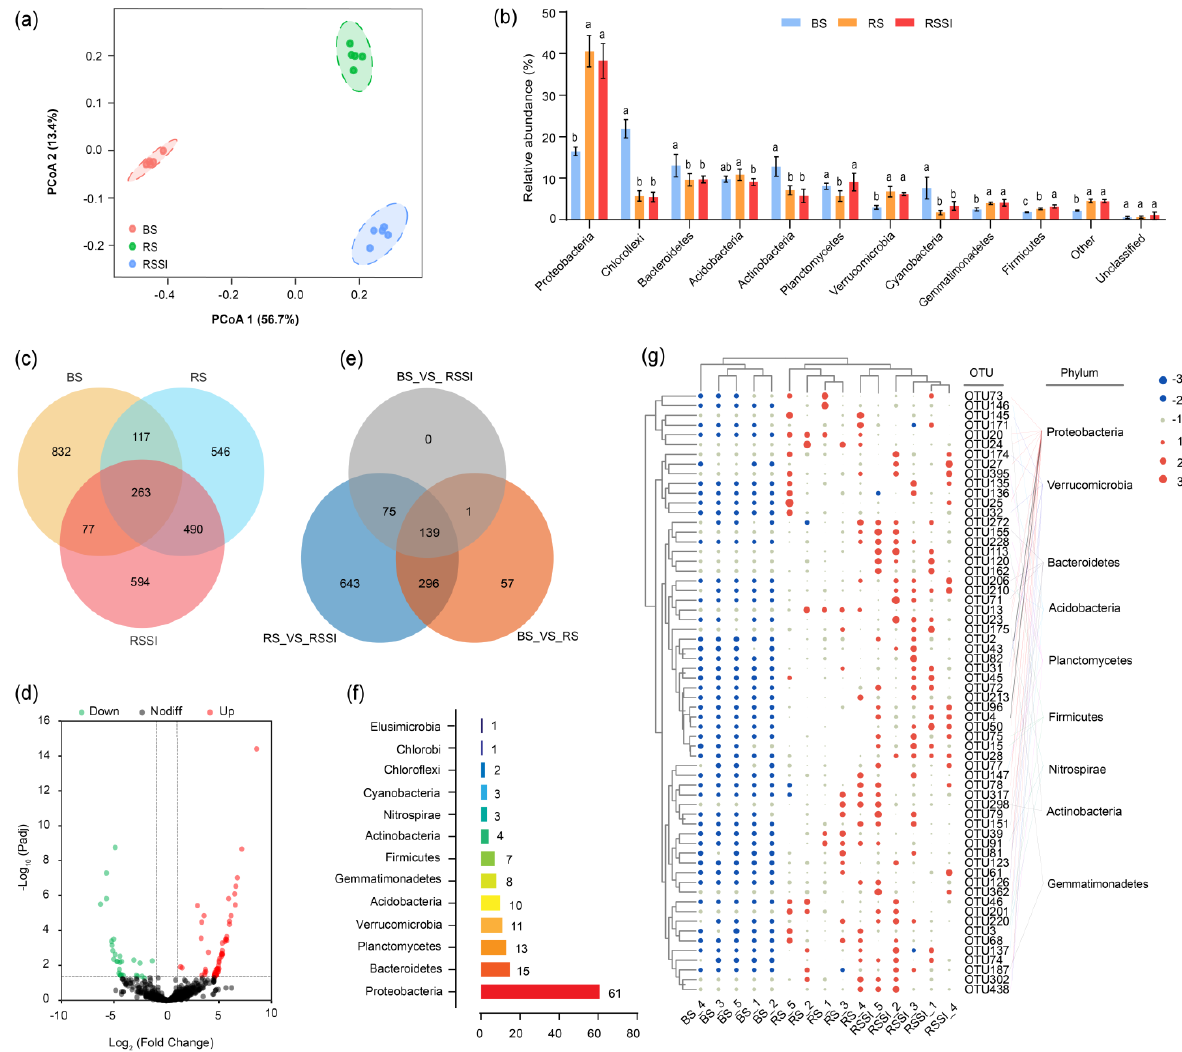
Figure 3. Impact of Si on the diversity of the rhizosphere soil bacterial community under R. solanacearum inoculation. ( a ) Beta diversity of the rhizosphere soil bacterial community. ( b ) Relative abundance of rhizosphere soil bacteria at the phylum level. ( c , e ) Venn diagrams illustrating the common and unique OTUs for each treatment and comparison group. ( d ) Differential relative abundance analysis showing up- and down − regulated OTUs under RS and RSSI treatments. ( f ) Bar chart presenting the number of common OTUs at the phylum level for the comparison groups. ( g ) Cluster heat map visualizing common OTUs among comparison groups (relative abundance > 0.1%).